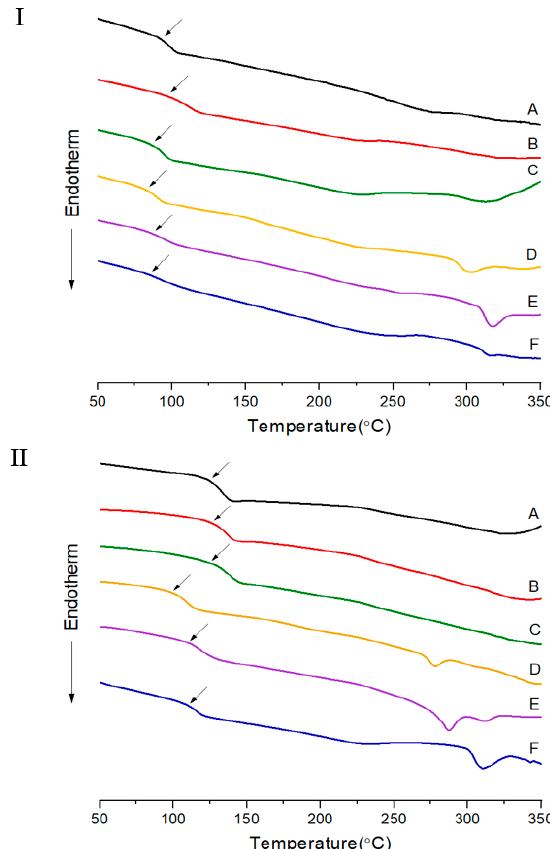
Figure 2. DSC thermograms of TLCP-I and TLCP-II series.